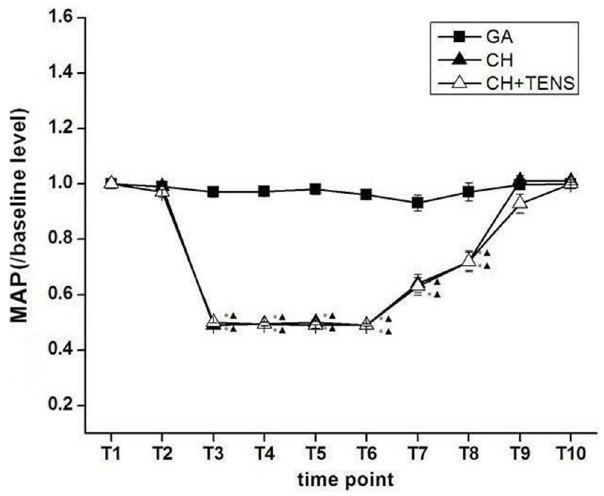
Figure 2. Stability of mean arterial pressure (MAP) levels during controlled hypotension (CH) in all animals. The figure shows that MAP levels in the CH and CH + TENS (2/100 Hz, bidirectional rectangle pulse with 0.6/0.2 ms pulse width,3–5 mA for more than 90 min) groups were kept stable at the target MAP during the maintenance stage of CH (50% of MAP baseline). Data are presented as mean 6 standard error of the mean. * P , 0.05 vs. general anesthesia (GA) group, m P , 0.05 vs. basal level, n=6 per group.